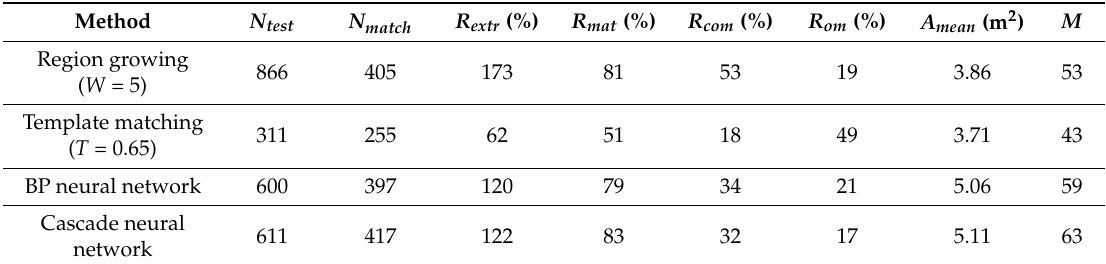
Table 6. Detection results for test area 6.